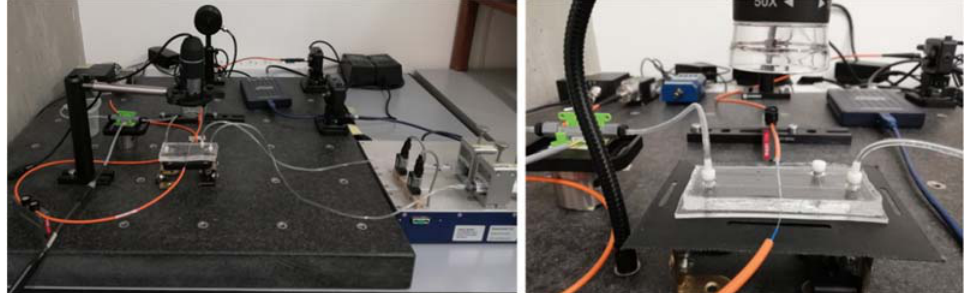
Figure 4. Pictures of the experimental setup used for the two-phase flow